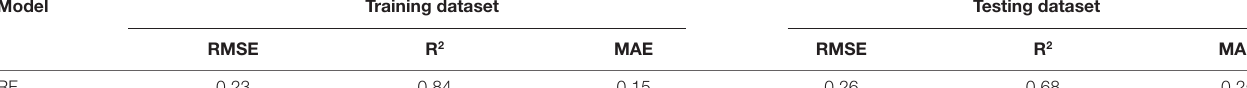
TABLE 5 | The average RMSE (kg m -2 ), R 2 and MAE (kg m -2 ) values for RF models with different trees to estimating AGB in the training and testing datasets. Model Training dataset